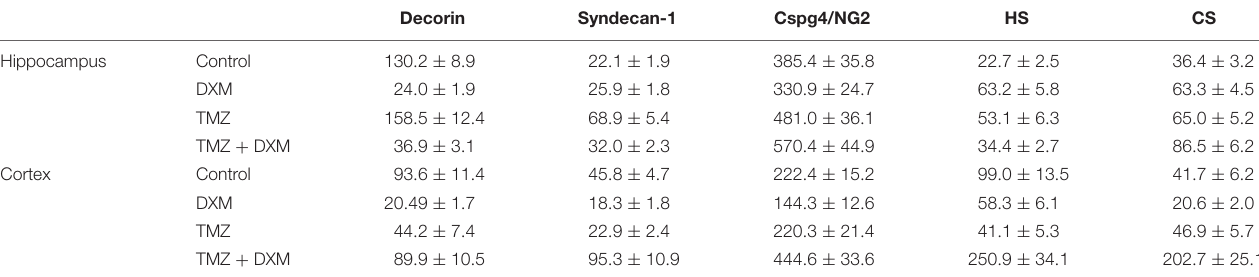
TABLE 3 | Immunofluorescence analysis of individual PG core proteins and GAG content in hippocampi and cortex of control and DXM and/or TMZ-treated Wistar rats. Decorin Syndecan-1 Cspg4/NG2 HS CS Hippocampus